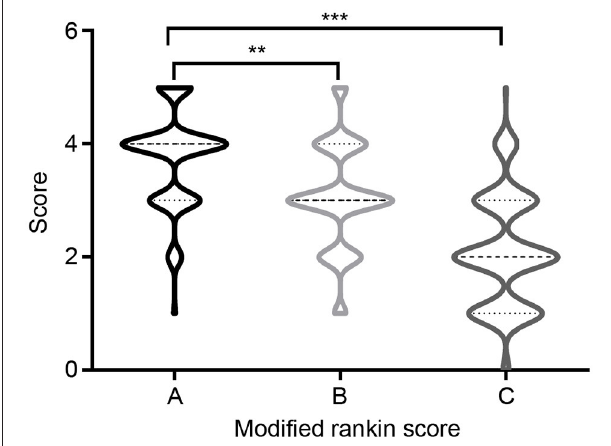
FIGURE 4 | Modified Rankin Scale (mRS) at onset and follow-up. (A) mRS at onset; (B) mRS at discharge; (C) mRS at 12-months follow-up. ** P < 0.01, *** P < 0.001.